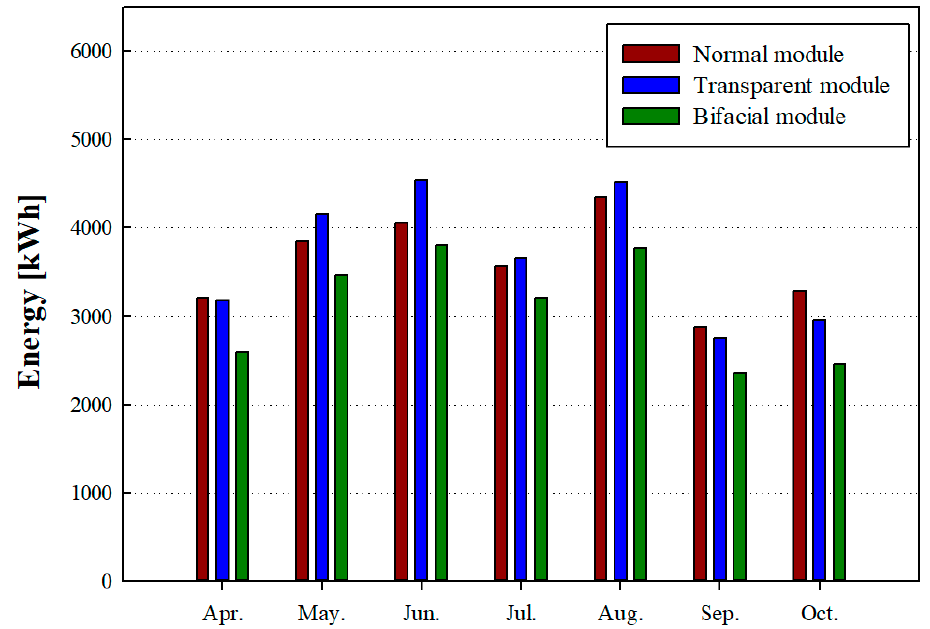
Figure 16. Generated energy of each module per month.